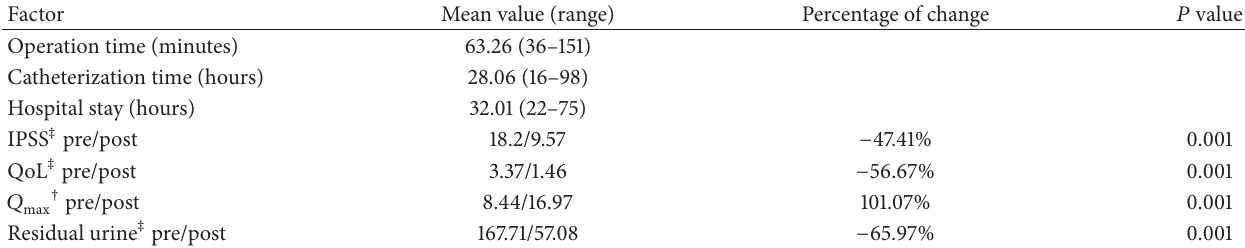
Table 2: Presentation of the operation time, catheterization time, hospital stay, and surgical results for the whole group of patients.